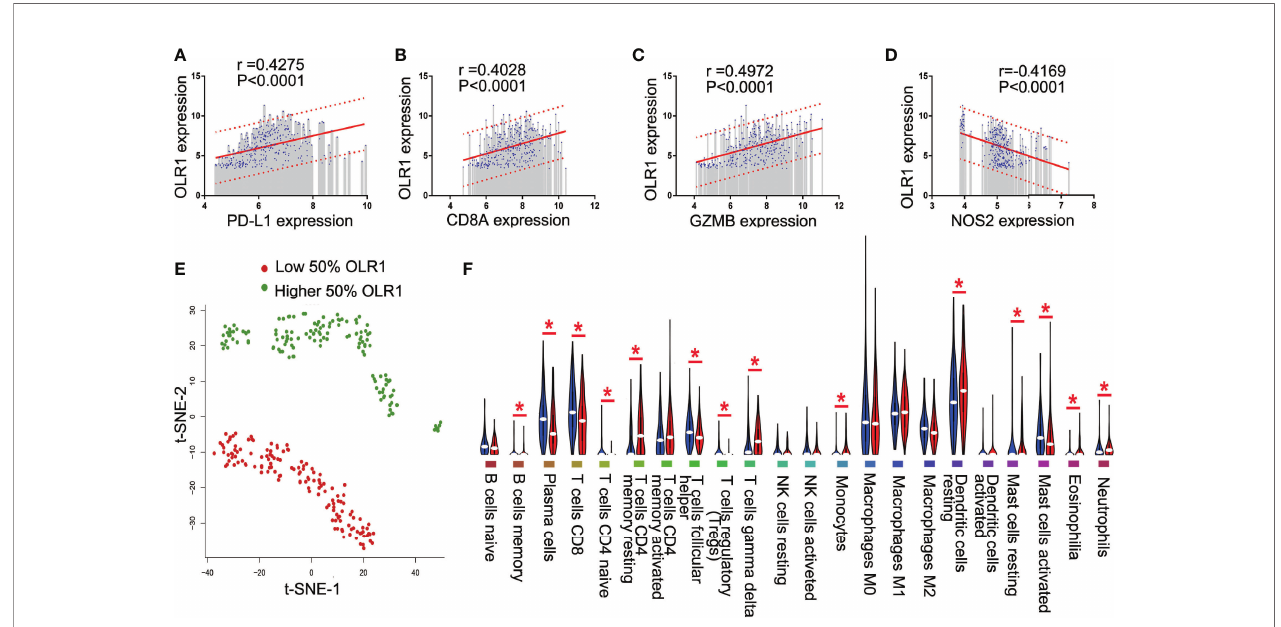
FIGURE 5 | OLR1 showed moderately strong correlations with 4 known immunotherapy biomarkers and its expression marked the TICs distribution. (A – D) OLR1 exhibited the highest correlation with PD-L1, CD8A, GZMB, and NOS2; (E) OLR1 expression could divide overall status of TICs distribution; (F) Violin plot showed the ratio differentiation of 22 kinds of TICs between higher 50% OLR1 expression tumor samples and lower 50% OLR1 expression tumor samples.